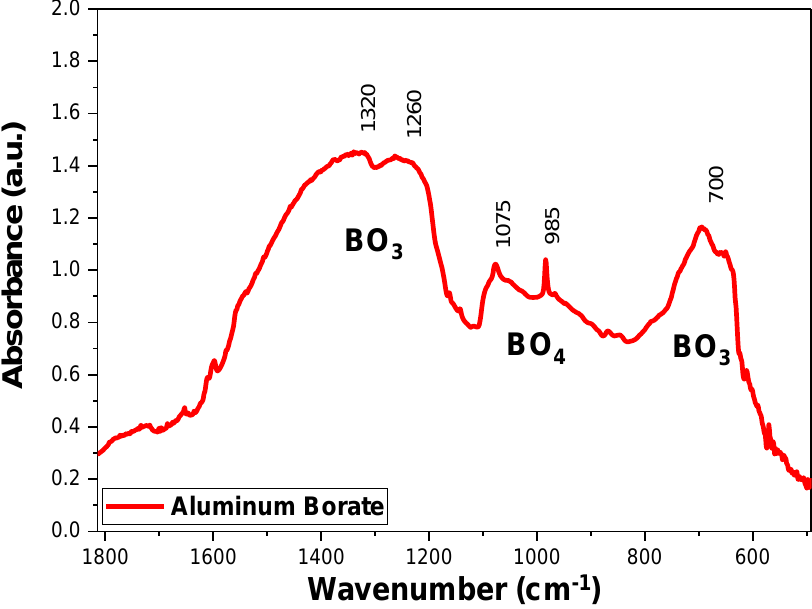
B O ), which was obtained by processing the 18 4 33